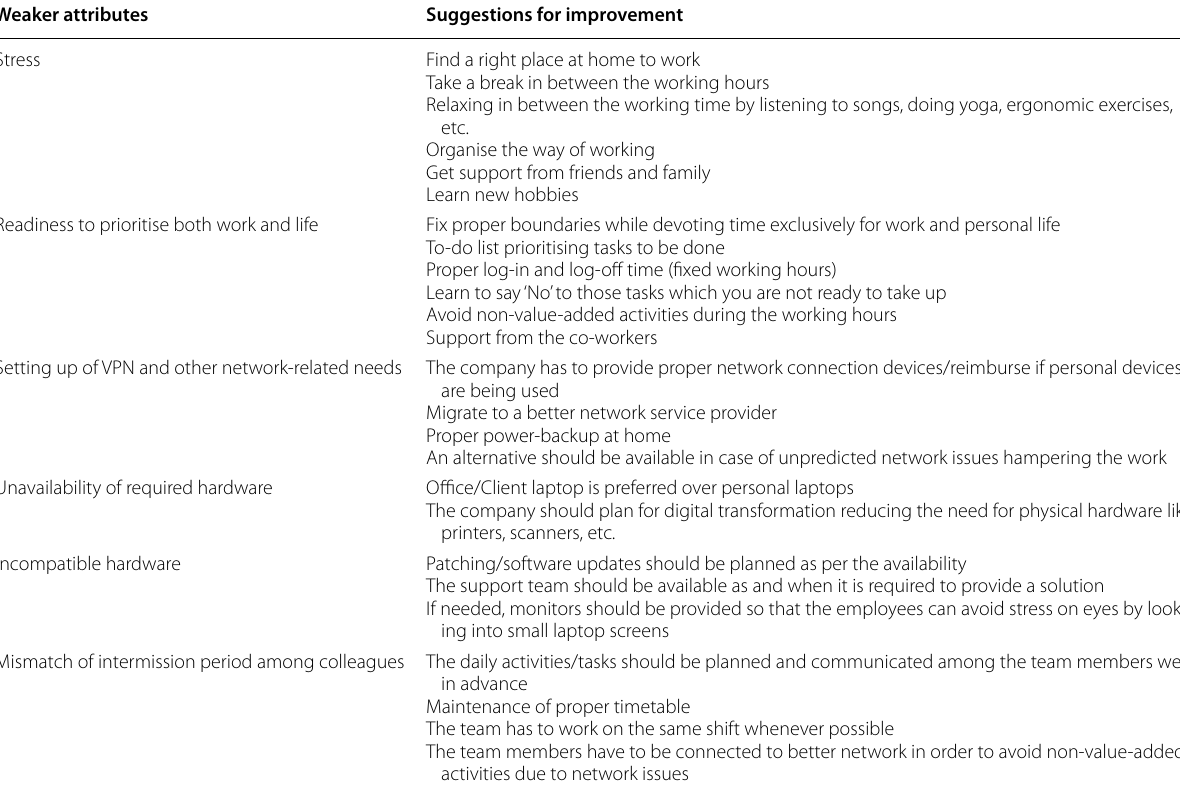
Table 5 Identified weaker attributes and decisions suggested for their improvement Weaker